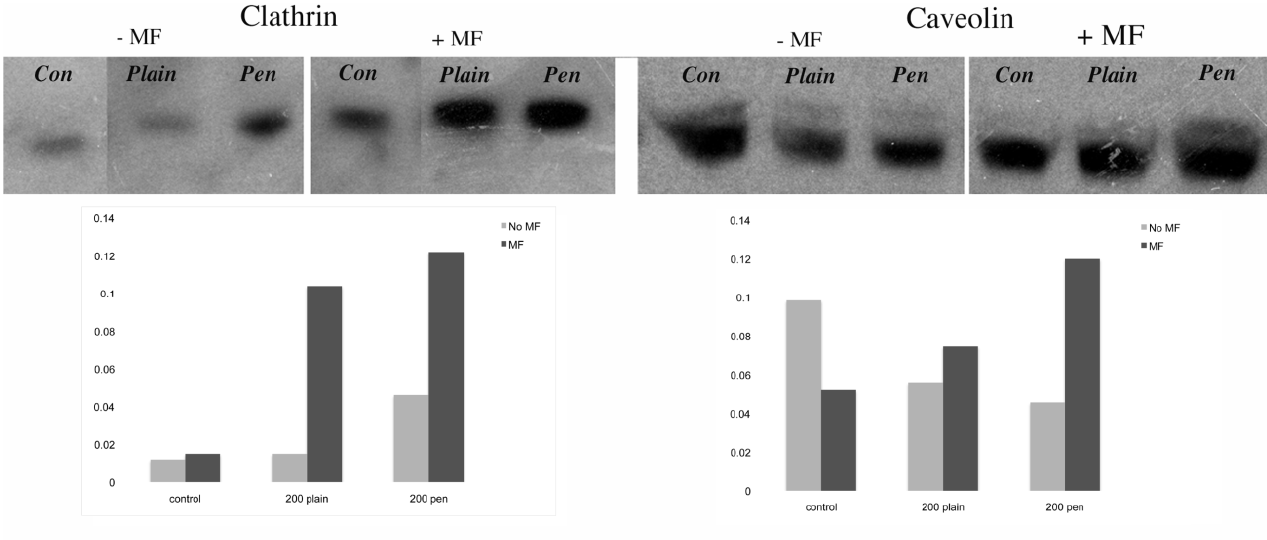
Figure 6. Clathrin and caveolin protein levels as assessed by western blotting, with band intensity analysed via Image